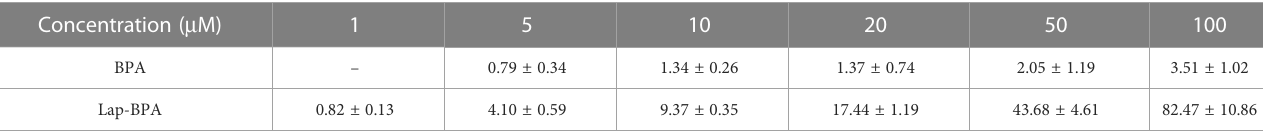
TABLE 2 The exact concentrations of BPA and Lap-BPA in PBS were determined by liquid chromatography. Concentration ( m